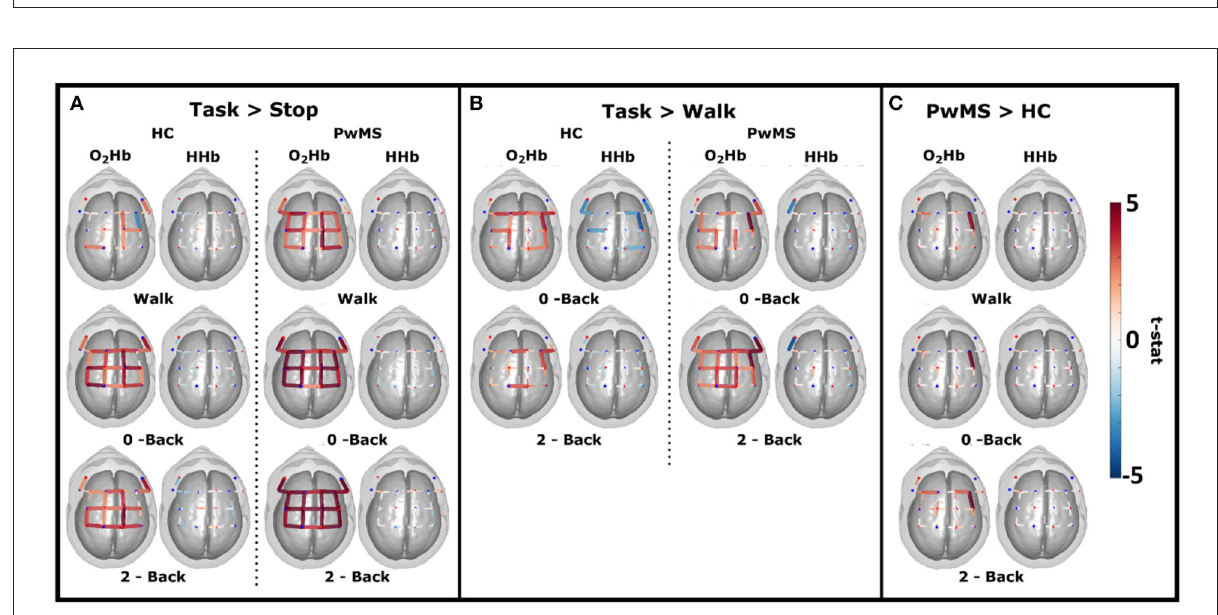
FIGURE4 Cortical maps of all channels showing the significant t-statistic effect of oxi- and deoxyhemoglobin (O 2 Hb and HHb) from 19 healthy controls (HC) and 20 patients with MS (PwMS). (A) Intra-group contrast during cognitive dual tasks (0-back and 2-back) and walk relative to the rest period. (B) Intra-group between the cognitive dual tasks (0-back and 2-back) and walk. (C) Inter-group contrast during cognitive dual tasks (0-back and 2-back) and